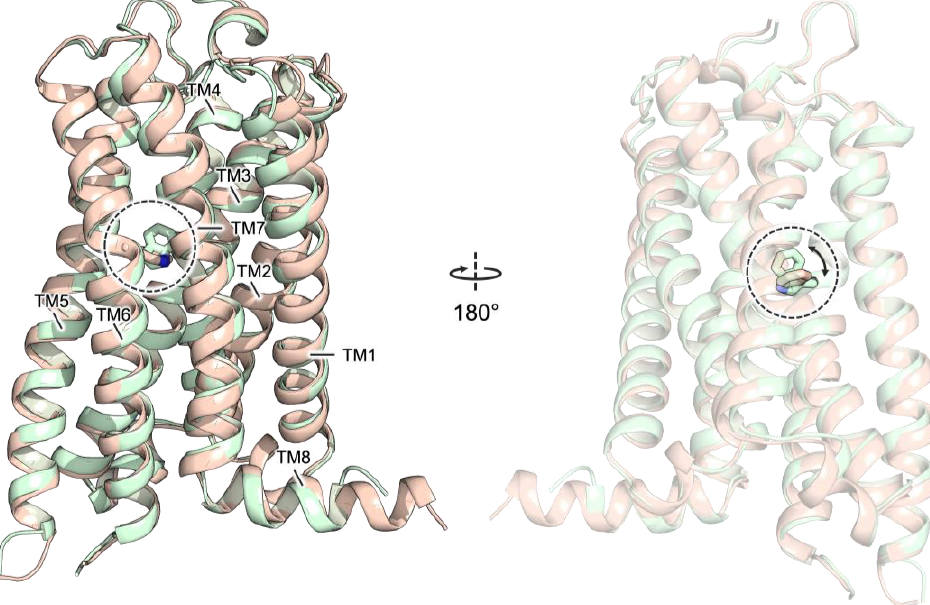
Figure 4. Superposition between the agonist (light green) and antagonist (light orange) conformations of hCB2R (PDB IDs 6KPC and 5ZTY, respectively). The transmembrane helices are labeled as TM1-8; residue Trp258 is reported as sticks and highlighted by a dashed circle. The rotation of Trp258 between agonist and antagonist structures is indicated by an arrow.